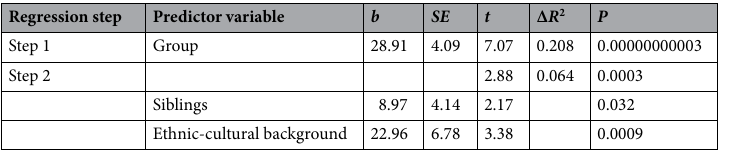
Table 1. Summary of hierarchical multiple regression analysis with percent of trials with active giving as criterion ( N = 192). Because the criterion had a limited number of possible values and groups displayed different variances, we also modeled the data using RLM macro, version 1.01 92 , with HC = 3-type robust standard errors. The results using robust standard errors 93 remained substantively the same both in Step 1 and Step 2, with all predictors remaining P <